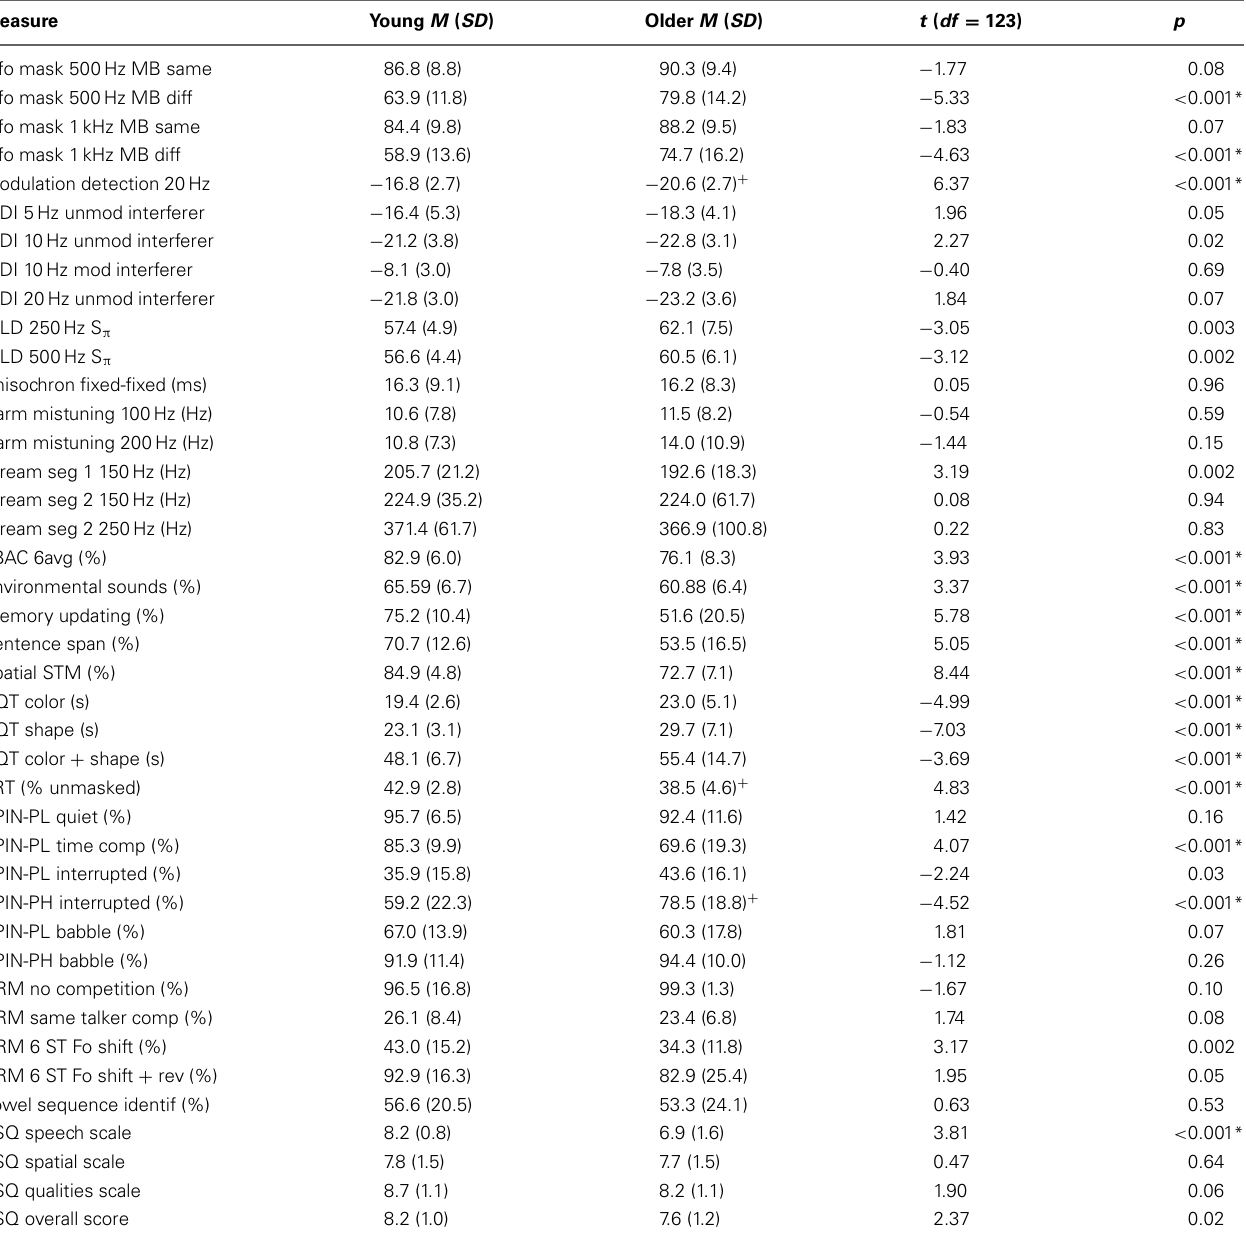
Table 2 | Means (M) and standard deviations (SD) for the groups of young ( N = 27) and older ( N = 98) adults.